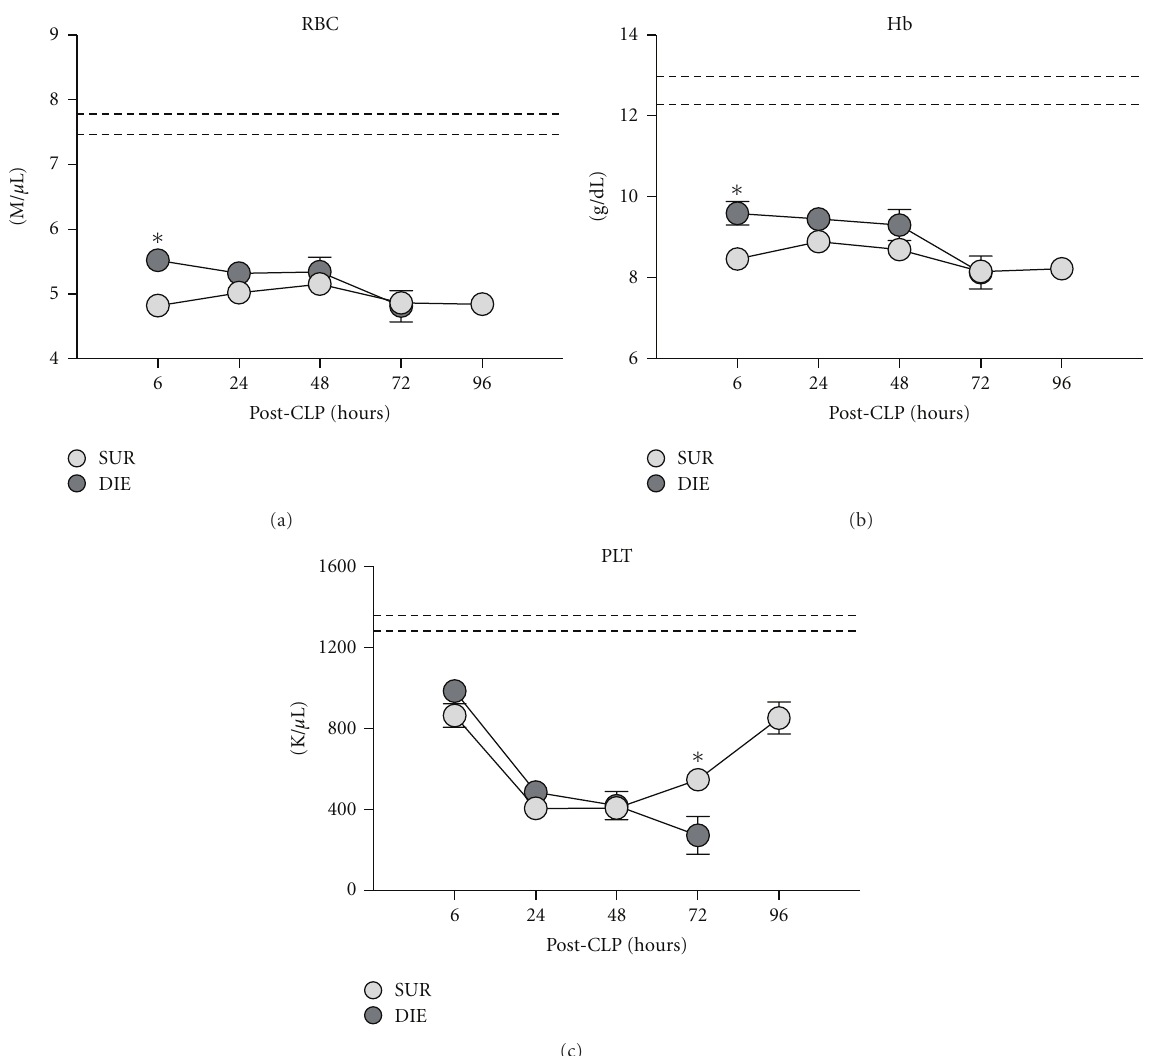
Figure 6: Retrospective comparison of red blood cell platelet count, and hemoglobin concentration in dying (DIE) versus surviving (SUR) animals after-CLP. 3-month-old female mice were subjected to trauma/hemorrhage followed by polymicrobial CLP-induced sepsis. Displayed values were compared between DIE and SUR group 6h (DIE at least n = 30, SUR at least n = 32), 24h (DIE at least n = 28, SUR at least n = 31), 48h (DIE at least n = 16, SUR at least n = 31), 72h (DIE at least n = 11, SUR at least n = 32), and 96h (SUR at least n = 26 for all parameters) after-CLP. Dotted lines represent normal values. ∗ P < .